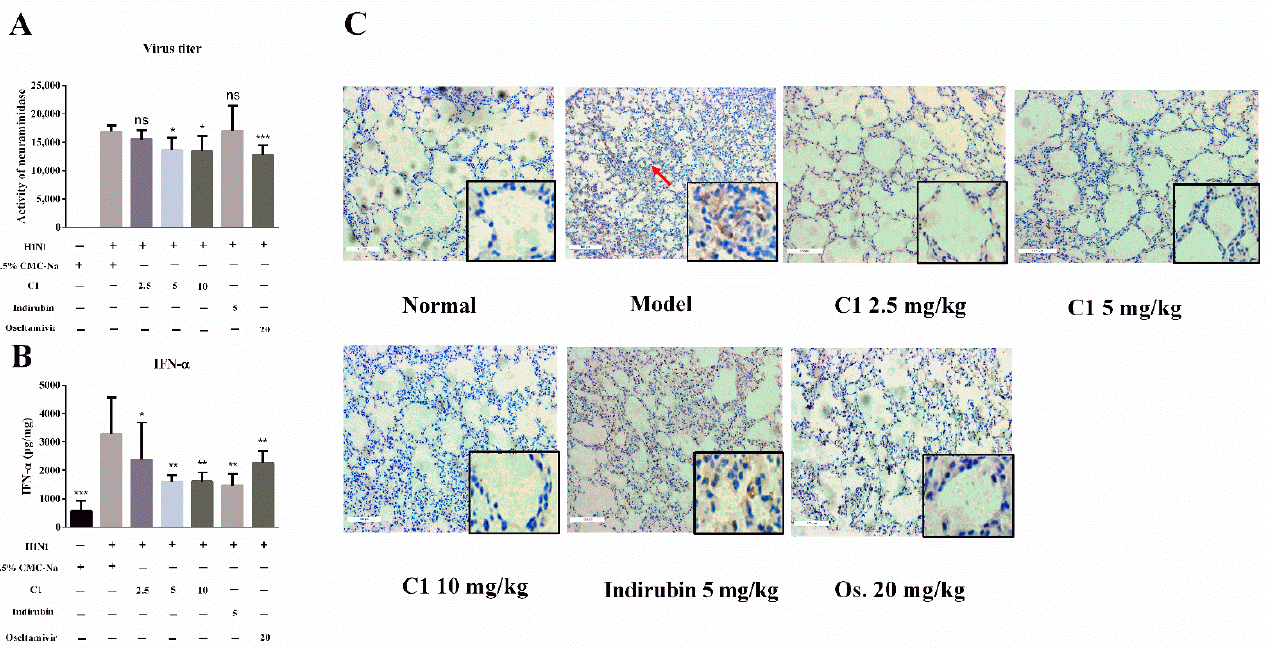
Figure 4. Suppression of H1N1 viral replication in vivo by C1, the experimental protocol is the same as Figure 3. ( A ) The NA activity in lung homogenates by fluorescence effect; ( B ) The expression level of INF- α in lung homogenates by ELISA; ( C ) The expression of NP in lung tissue, the representative IHC pathological images of the lung on day 4 post-infection, the red arrow indicates viral N protein- positive signal. Magnification: 200 × and 400 × ; scale bars, 100 µ m. * p < 0.05, ** p < 0.01, *** p < 0.001, compared with model